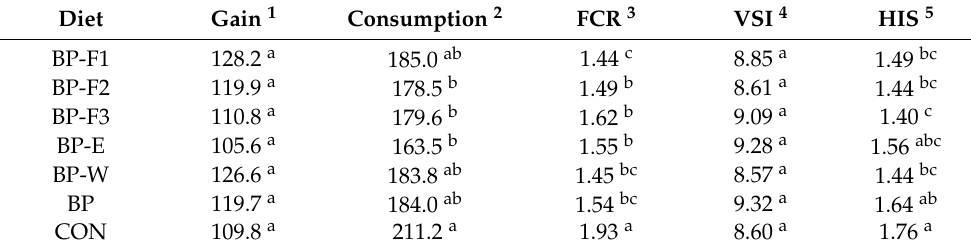
Table 3. Mean of performance indices for each dietary treatment over a 15 week trial.